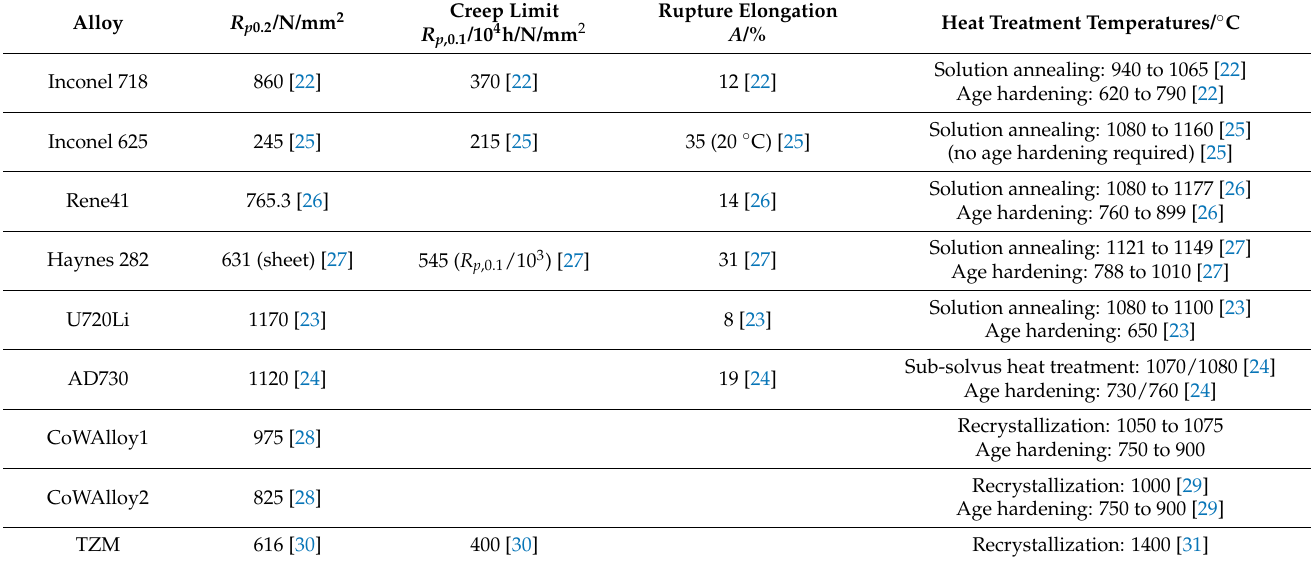
Table 4. Relevant parameters of the considered high temperature alloys at 650 ◦ C (unless otherwise stated). Mechanical properties refer to the solution-annealed/recrystallized and age-hardened condition for the precipitation-hardened alloys. The mechanical properties of TZM refer to the stress-relieved